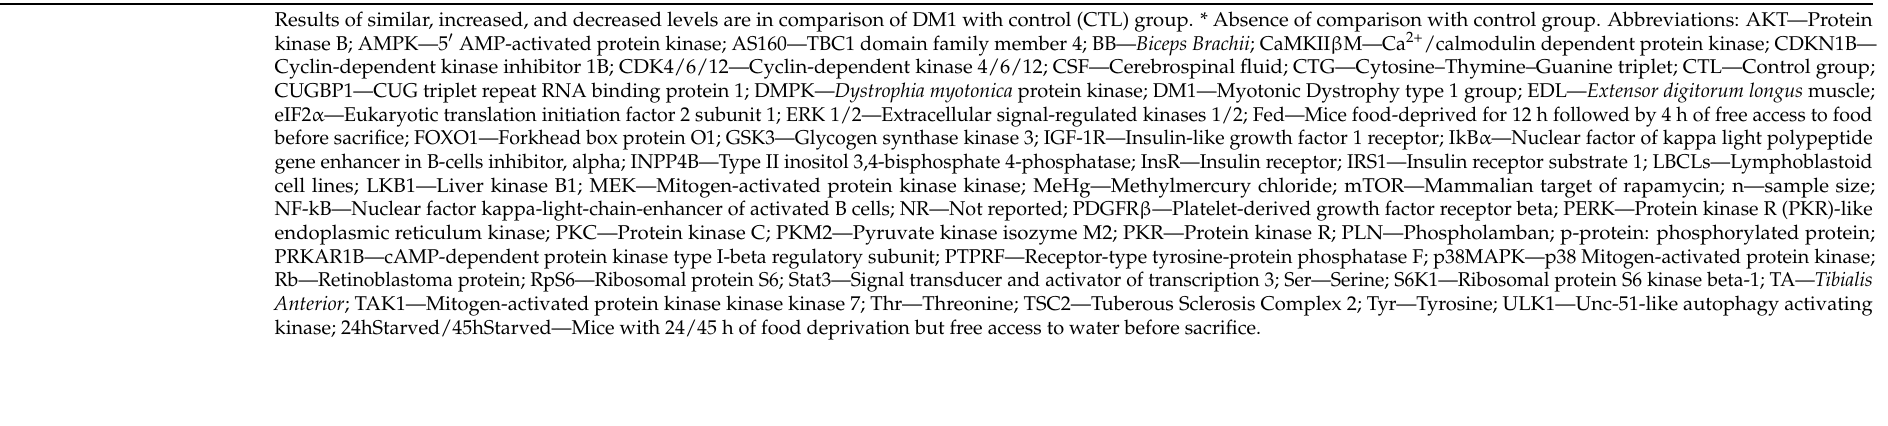
Anterior ; TAK1—Mitogen-activated protein kinase kinase kinase 7; Thr—Threonine; TSC2—Tuberous Sclerosis Complex 2; Tyr—Tyrosine; ULK1—Unc-51-like autophagy activating kinase; 24hStarved/45hStarved—Mice with 24/45 h of food deprivation but free access to water before